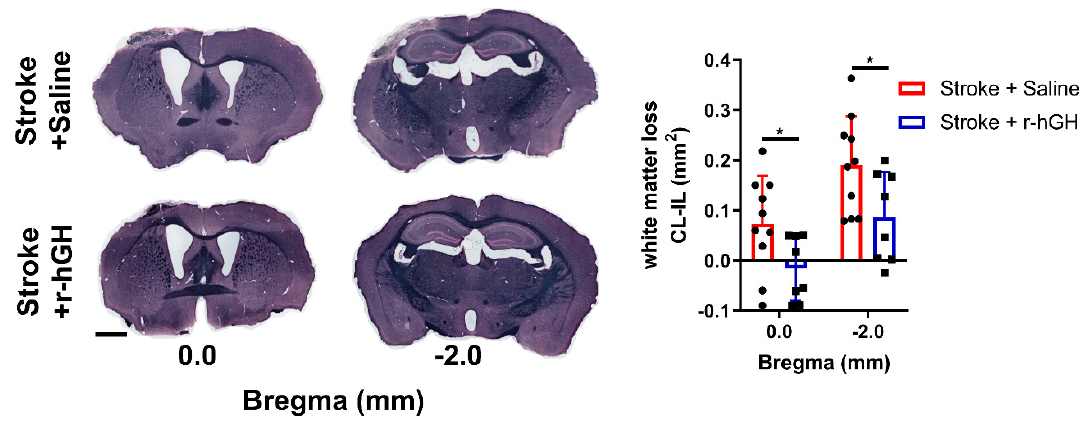
Figure 5. Sudan black staining of white matter tracts from the corpus callosum (Bregma 0.0 mm and − 2.0 mm). White matter loss was calculated as contralateral hemisphere area—ipsilateral hemisphere area (mm 2 ). Mean ± SD. * p < 0.05. Scale bar = 1 mm.